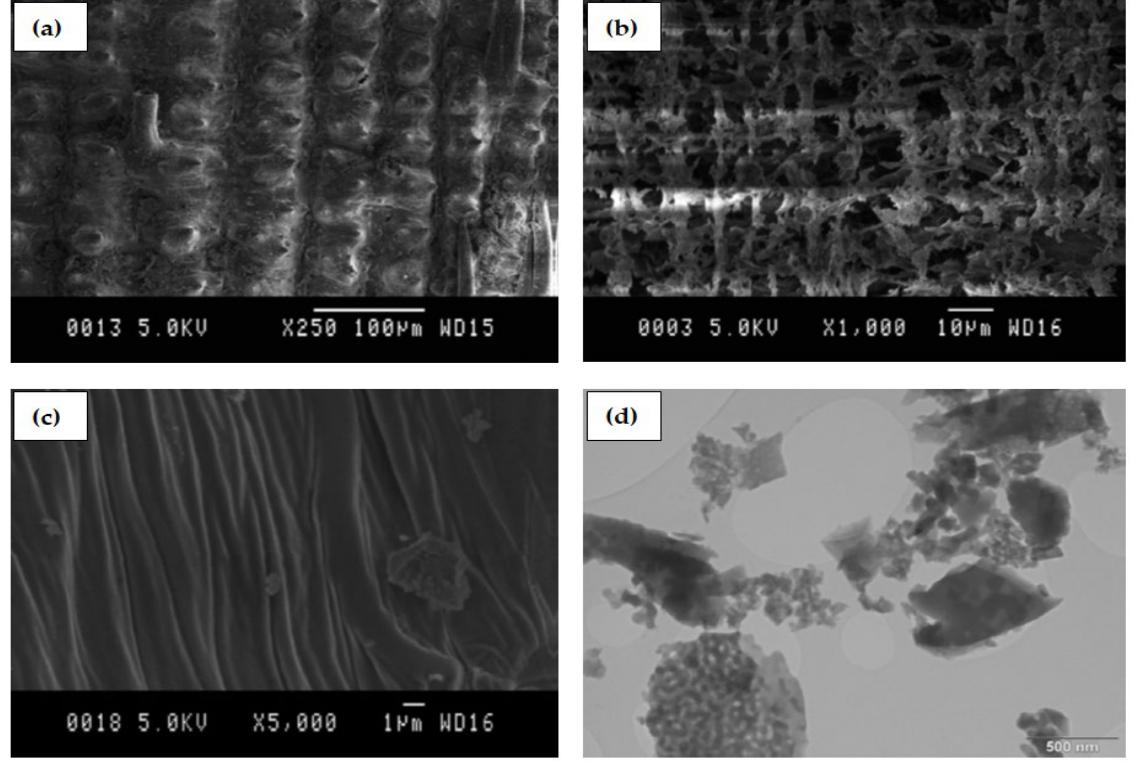
Figure 1. Micromorphology of rice husk ash (RHA) showing ( a ) outer surface ( b ) inter layer ( c ) Inner surface ( d ) transmission electron microscopy (TEM) image of RHA [63].